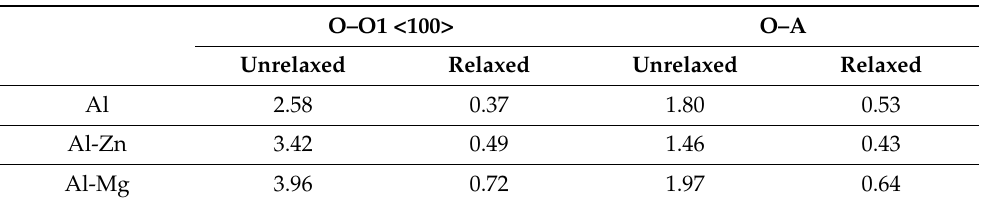
Table 3. The unstable stacking fault energies γ us (J/m 2 ) for GB sliding in two easy directions, with and without structural